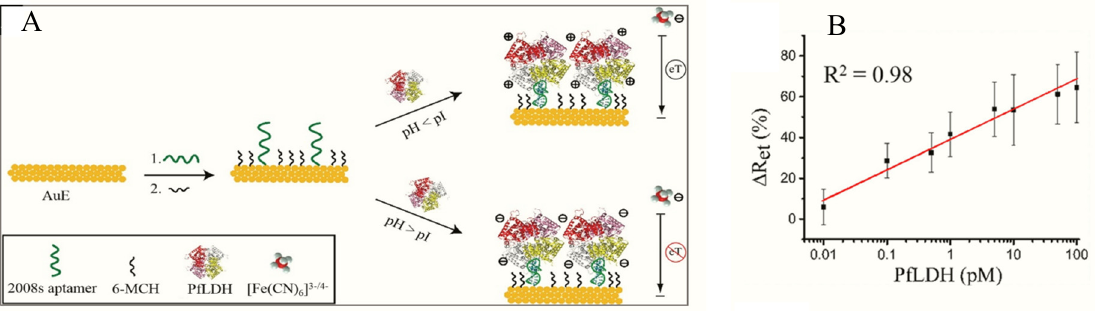
Figure 3. (A) Schematic representation of the PfLDH aptasensor and (B) calibration plot for 0.01 pM–10 Figure 3. ( A ) Schematic representation of the PfLDH aptasensor and ( B ) calibration plot for 0.01 pM– nM PfLDH in 5 mM [Fe(CN)6] 3 − / 4 − solution at pH 7.5. (Reprinted from Figueroa-Miranda et al. 10 nM PfLDH in 5 mM [Fe(CN)6] 3 − /4 − solution at pH 7.5. (Reprinted from Figueroa-Miranda et al. [89] with permission from Elsevier).